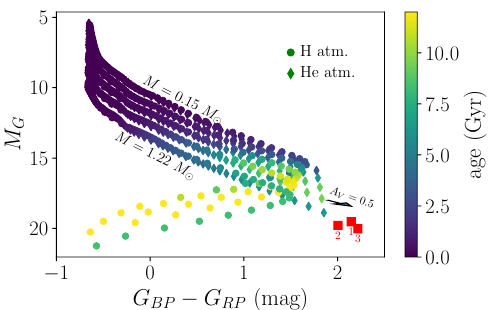
Figure 7. Gaia colour-magnitude diagram comparing Candidates #1-#3 to model cooling sequences of hydrogen-atmosphere and helium-atmosphere white dwarfs. The models plotted derive from [72– 74], and [75], combined and disseminated in [76]. Also shown is a reddening vector, corresponding to 0.5 visual magnitudes of dust extinction as estimated by